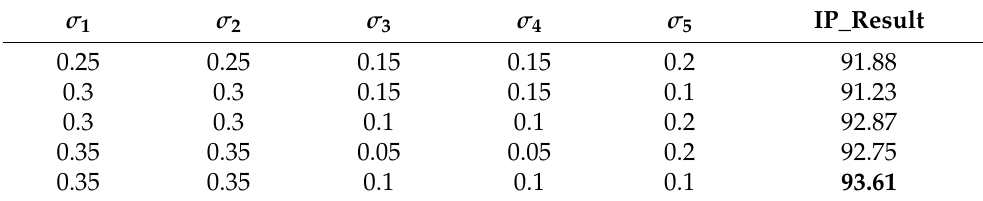
Table 13. Investigation of the proportion σ i of loss functions in IP dataset with 5% training